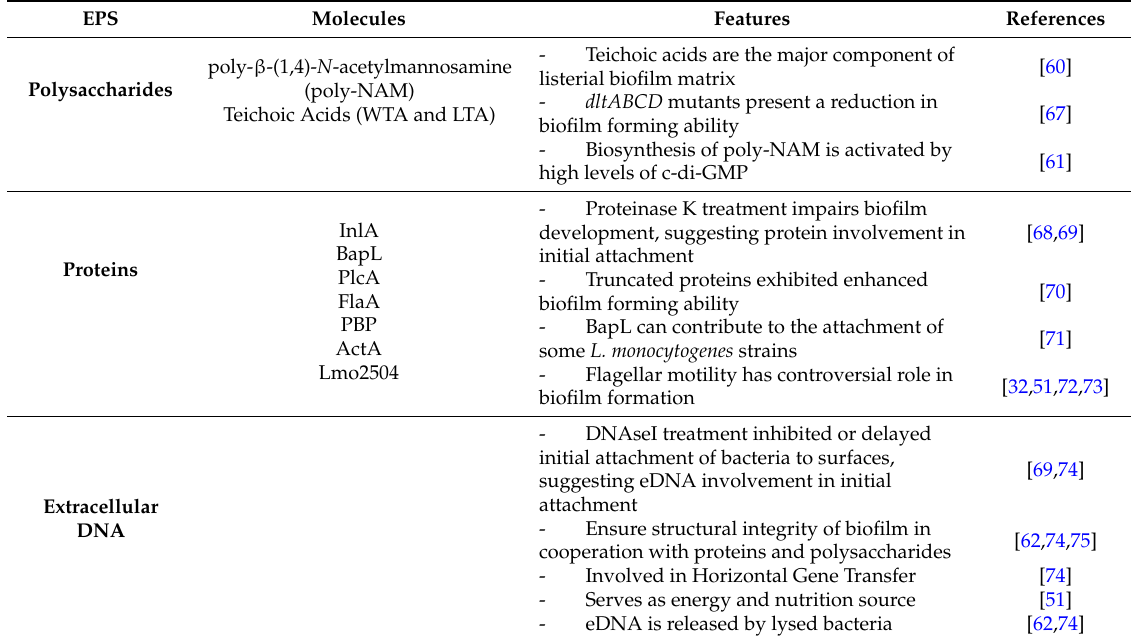
Table 1. Structural components of Listeria monocytogenes extracellular matrix. EPS’s characterized so far and their role within biofilm matrix are listed